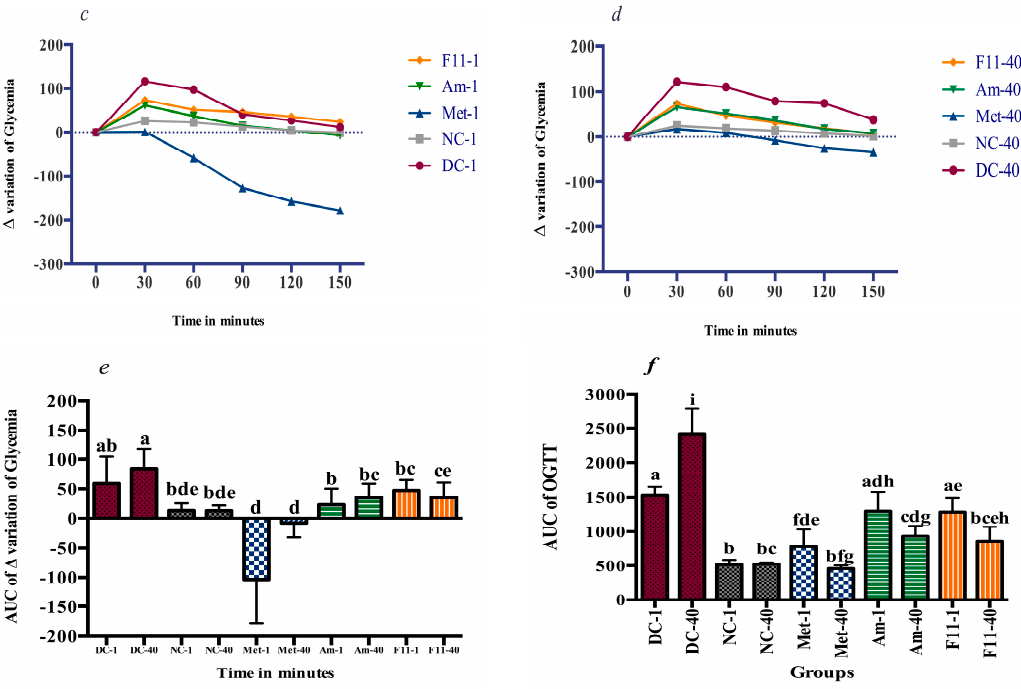
Figure 3. Oral glucose tolerance before and after treatment period. ( a ) OGTT of the first day 1; ( b ) OGTT of the day 40; ( c ) Δ variation of glycaemia during OGTT-Day 1; ( d ) Δ variation of glycaemia during OGTT-Day 40; ( e ) AUC of Δ variation of glycaemia during OGTT challenge; ( f ) AUC of OGTT, Data are reported to mean ( n = 8) ± SD. Values not sharing a common letter (a–i) differs significantly at p < 0.05.